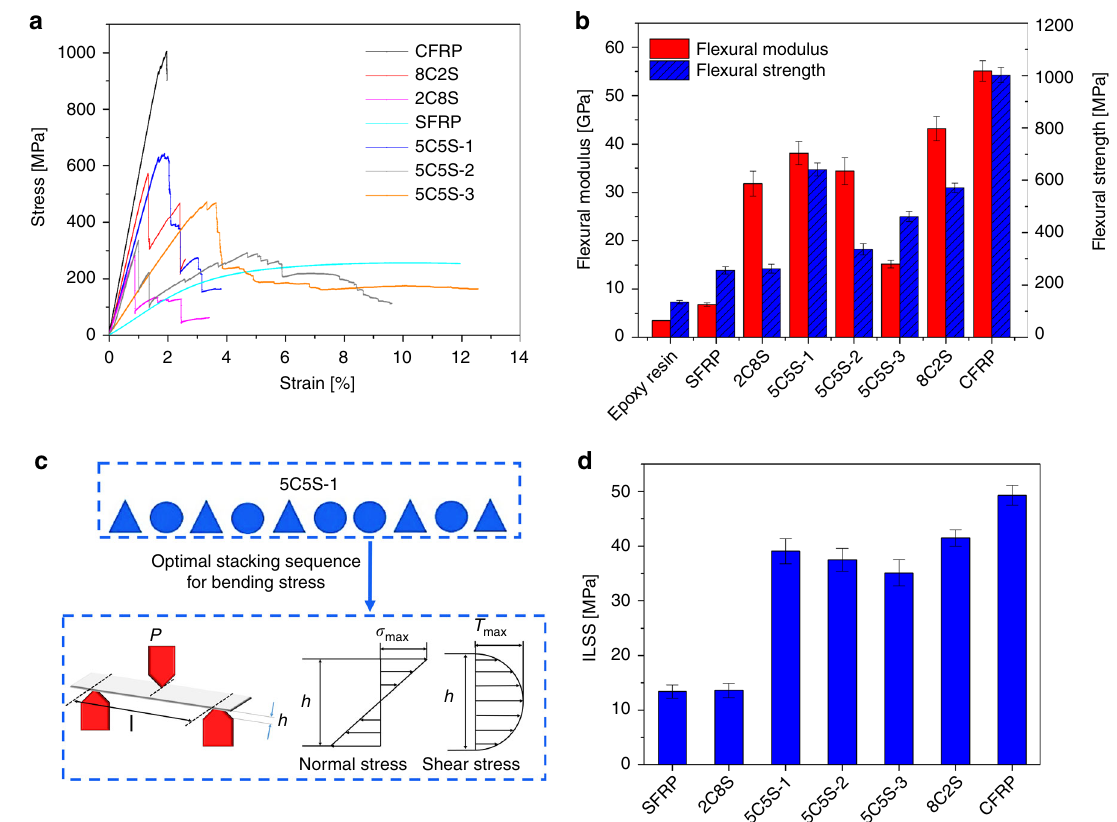
Fig. 4 Flexural and interlaminar shear properties of composites. a Typical fl exural stress – strain curves of CFRP, SFRP and HFRPs with various hybrid ratios and stacking sequences for the 5C5S composition. b Modulus and strength of CFRP, SFRP and HFRPs with various hybrid ratios and stacking sequences. c Stacking sequence of 5C5S-1 and distribution of normal stress and shear stress under the three-point bending mode. d Interlaminar shear strength (ILSS) of the CFRP, SFRP and HFRP composites with different hybrid ratios and stacking sequences. The error bars represent the standard deviation of measured